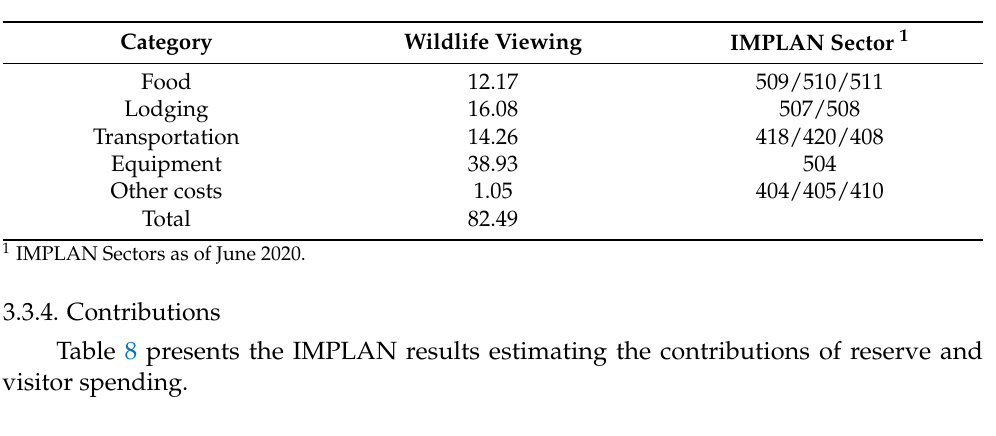
Table 7. Per-person-per-day visitor expenditures in Oregon by category with corresponding IM- PLAN